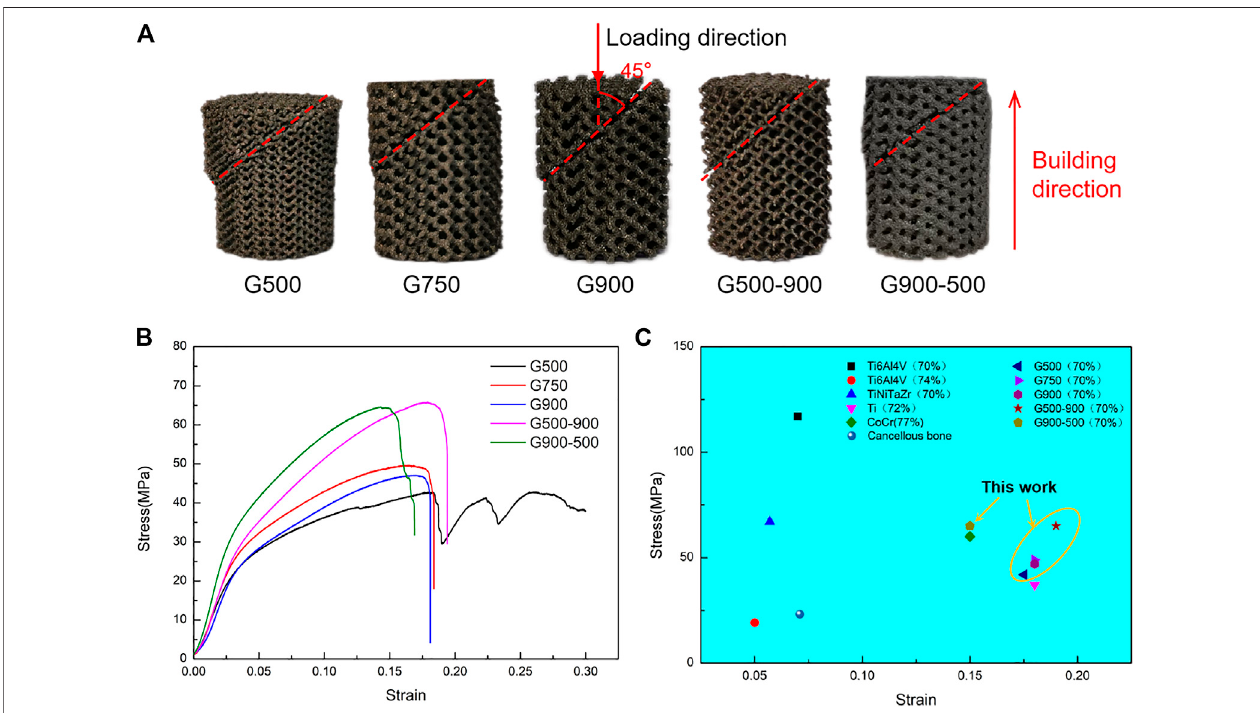
FIGURE5| Compressionpropertiesofthe scaffolds: (A) morphologies ofthepost-compression test, (B) compression stress – strain curve, and (C) comparison of mechanicalpropertiesofthescaffoldwithdifferentmaterialsundersimilarporosity(Sevillaetal.,2007;Ataeeetal.,2018;Cutoloetal.,2018;Cutoloetal.,2020;Liuetal., 2020; Luo et al., 2020).